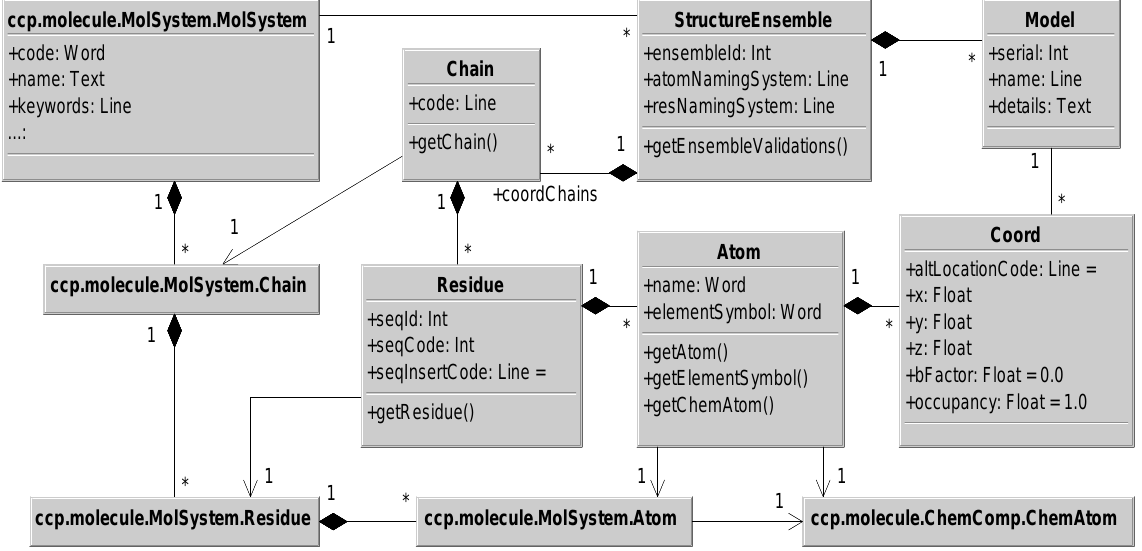
Supplementary Figure 5: Example package – 'MolStructure', used for storing molecular coordinate ensembles, with associated classes from other packages (names beginning with 'ccp.'). Classes are connected by 'parent-child' links (composition links - black diamonds). Each package has a TopObject class (here the StructureEnsemble) that is a child of the MemopsRoot (not shown). Links between classes are shown as dark lines – role names are derived from the names of the classes, except where explicitly overridden (e.g. 'coordChains'). One-way links are shown as arrows. Most methods are generated automatically. The few explicit operations in the diagram, like the Chain.getChain function, have non-standard code and are used to define derived